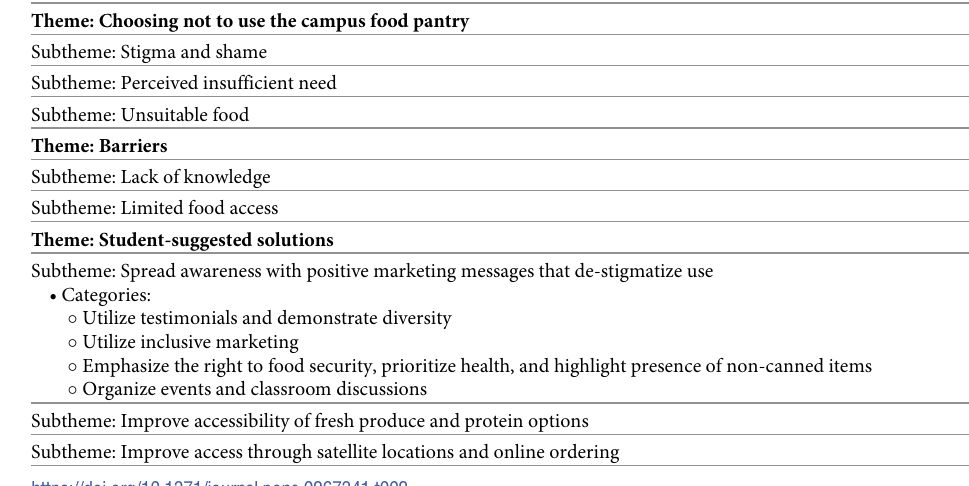
Table 2. Themes and subthemes from semi-structured interviews with university students (n = 41).